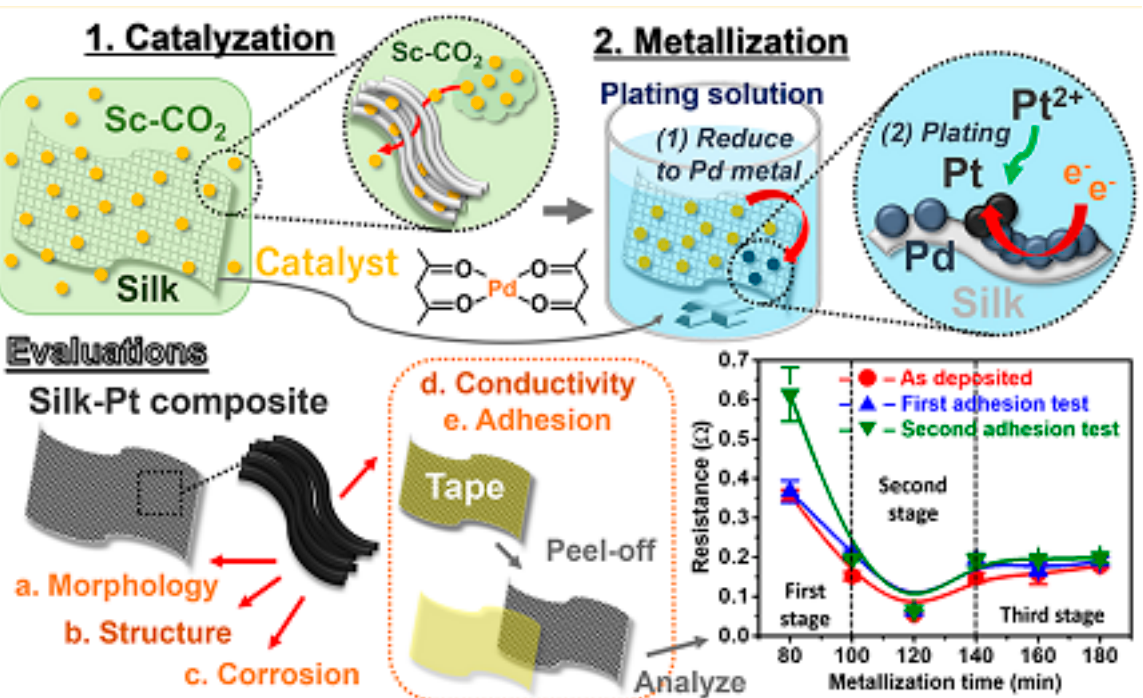
Figure 4. Outline of the development of biopolymer nanocomposite of silk and platinum using supercritical carbon dioxide. Reproduced with permission from [30] .